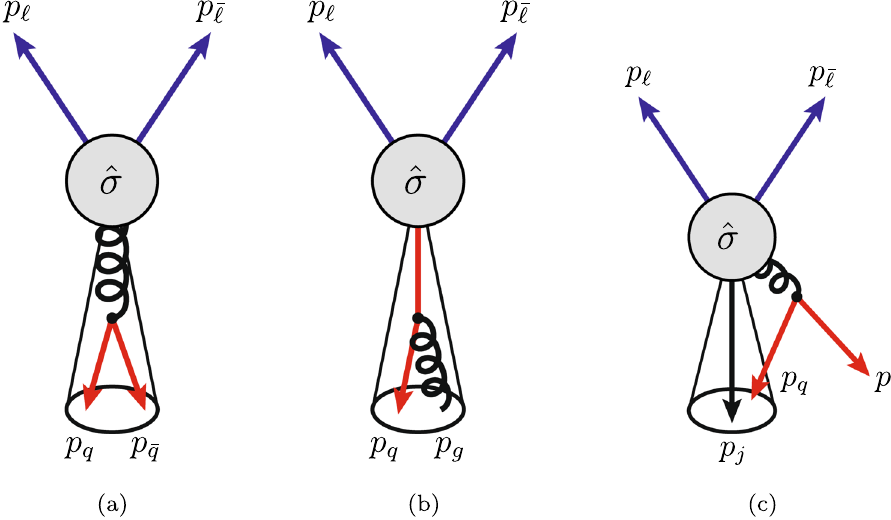
Fig. 6 Examples of configurations which lead to an IRC sensitivity: a a double (even) tagged jet; b a tag with a p min requirement; c a jet tag T , q with a soft sensitivity (in